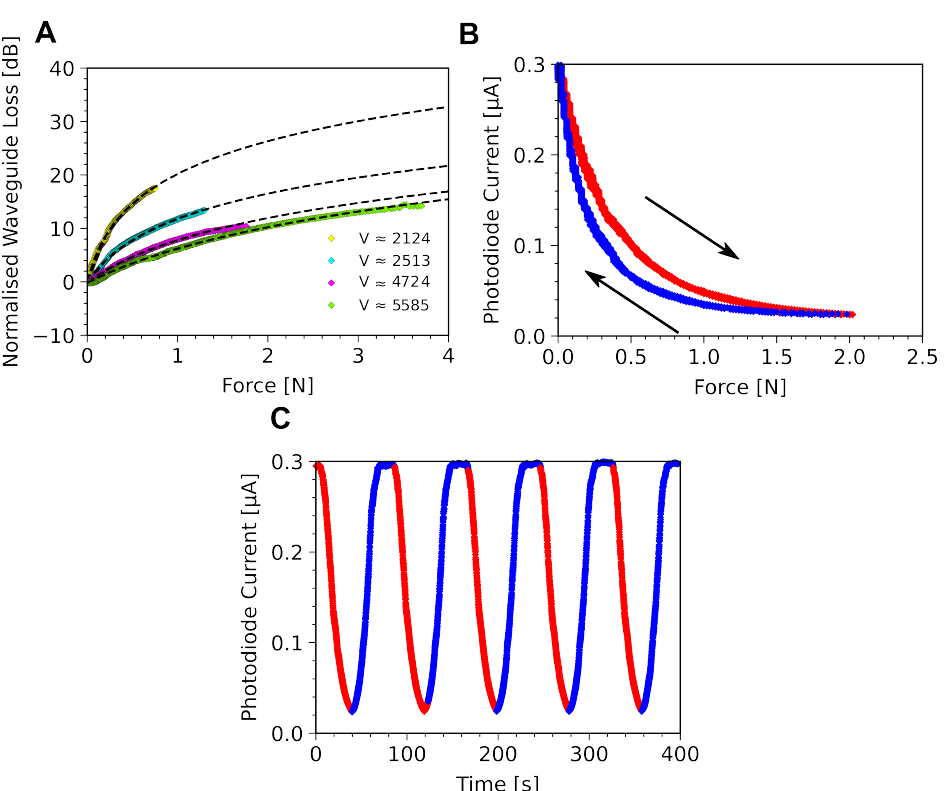
Figure 4. ( A ) Waveguide response for several normalised frequency values, V, calculated from Equation (1). Yellow: D = 180 µ m, λ = 0.532 µ m; Blue: D = 180 µ m, λ = 0.450 µ m; Magenta: D = 400 µ m, λ = 0.532 µ m; Green: D = 400 µ m, λ = 0.450 µ m; The black dashed lines show logarithmic fits to the data of the form A = a log ( x ) + c , where x is the compression force and a , b , and c are freely varying fitting parameters. ( B ) Curve of the photo-current versus the compression force for a single compression force cycle, red is increasing compression force, blue is decreasing compression force. Loading and unloading achieved with a linear compression rate of 5 mm/min. The hysteresis seen has an integrated area of 37 nA N for a single loading cycle. ( C ) Photo-current · over time as compression force is applied with a 20 s pause between cycles, red and blue data correspond to part ( B